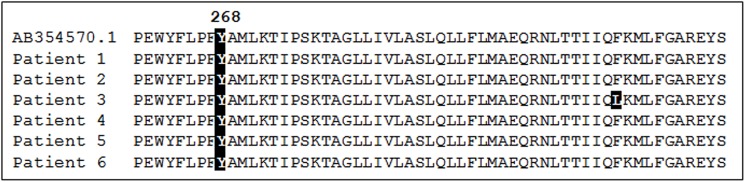
Gene sequencing results of second amplification products with previously published P. malariae cytochrome b sequence as reference.Y268 is clearly indicated by shading, showing the wild-type Y268 residue is present in all isolates. One residue differing from the reference sequence in patient 3 is highlighted.